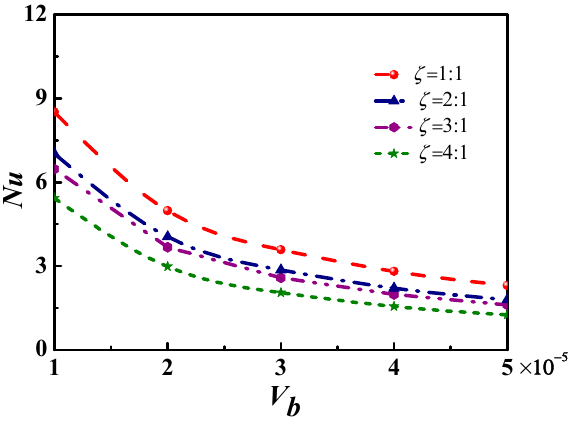
Figure 8. The Nu number changes with the Vb in the microchannel with different cross-sections, while the wall temperature is 323.15 K.